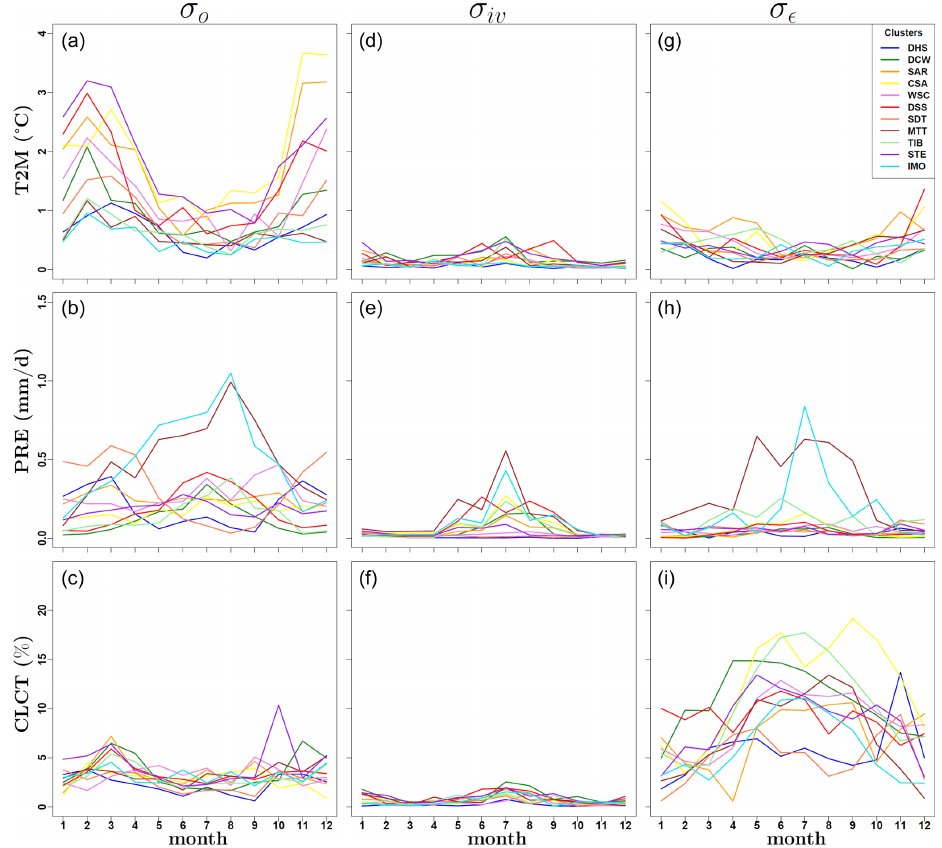
Figure 8. Values of different uncertainty terms for each cluster and month used in the PI calculations. From top to bottom, the different variables are considered, in the following order: near-surface temperature (T2M), daily precipitation (PRE) and total cloud cover (CLCT). Panels (a–c) represent the uncertainties of the observation interannual variability ( σ o ) calculated over the period of 1996–2005. In panels (d– f) , the values of the model internal variability ( σ iv ), calculated over the same period, are shown. In panels (g–i) , the errors calculated over the different observational data sets, for the selected year (2000), are illustrated ( σ (cid:15)